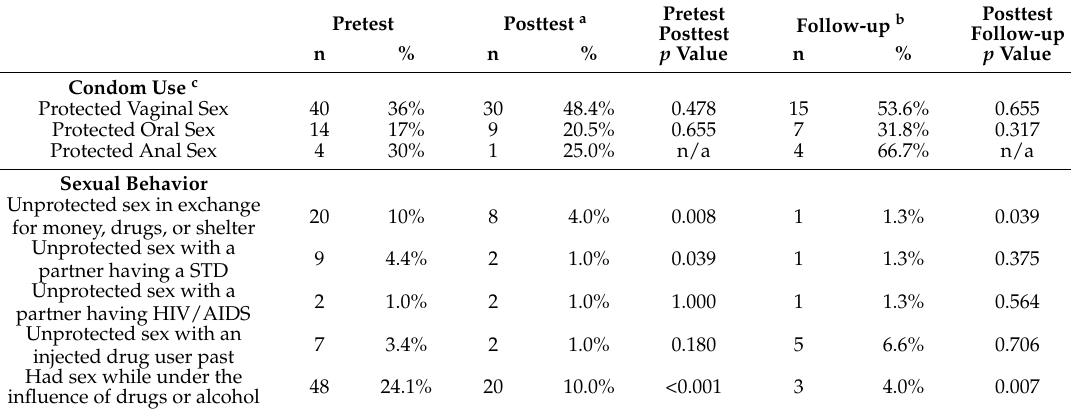
Table 4. HEAL program participant outcomes at pre-test, immediate post-test, and follow-up